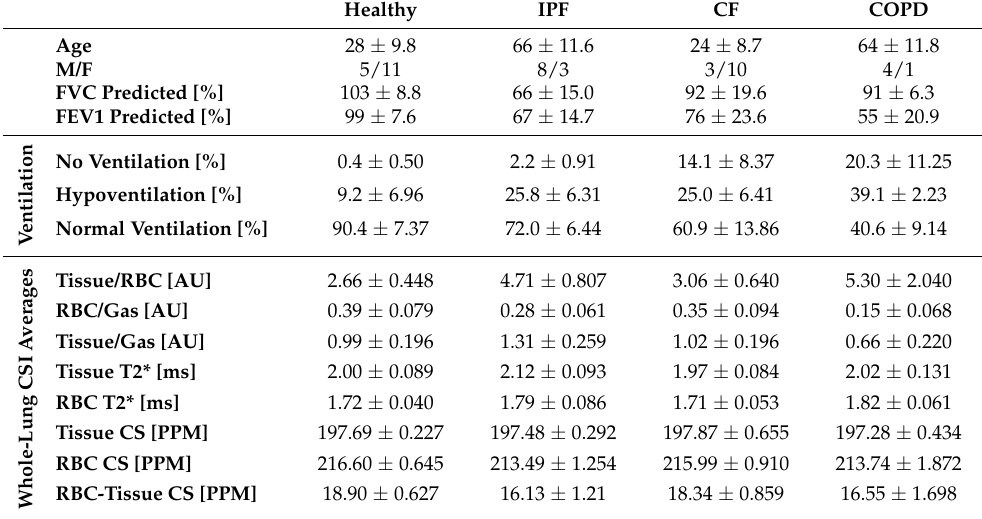
Table 1. Averages and standard deviations for subjects and computed parameters for each dis- ease type.